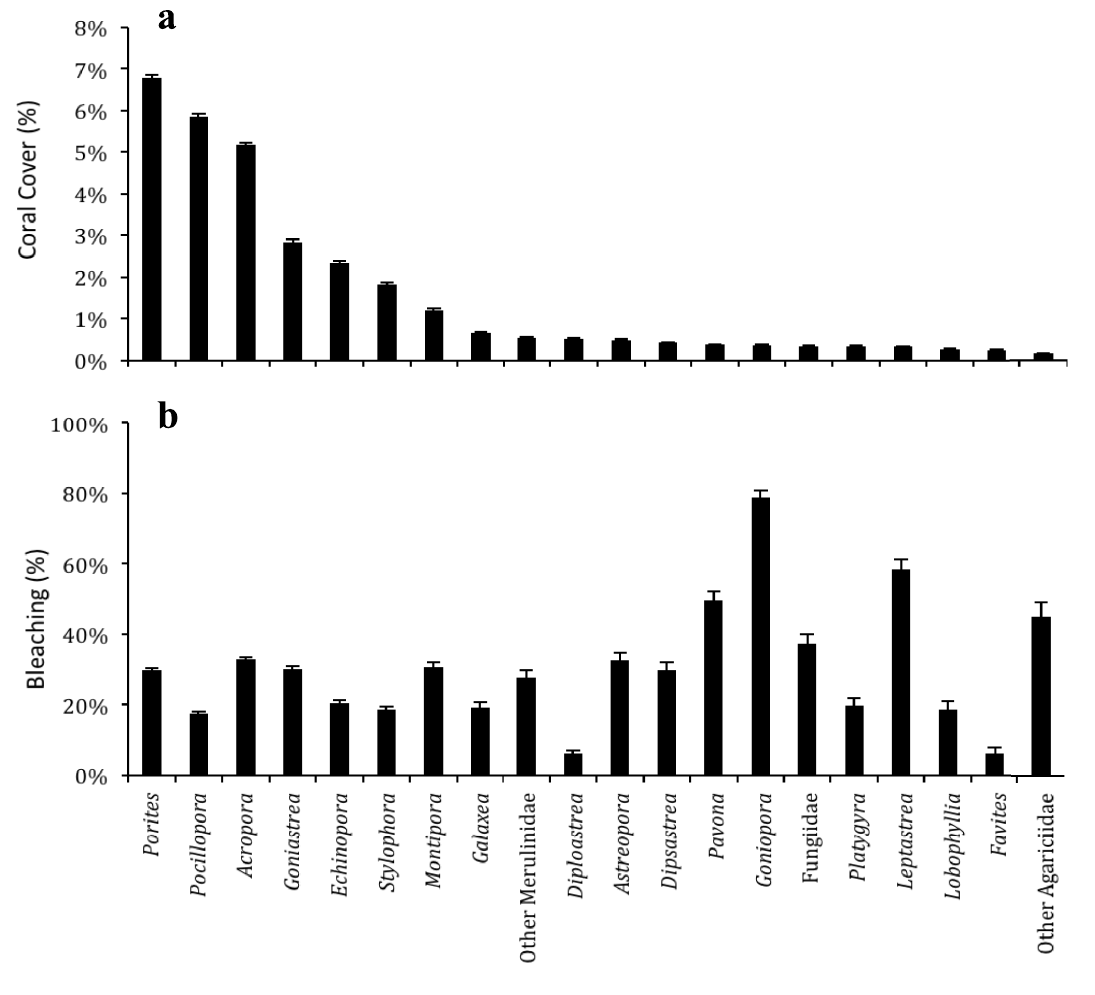
Fig 4. Percentage of scleractinian coral cover and their sensitivity to thermal stress during a bleaching event in the central Saudi Arabian Red Sea. a Average percent coral cover of the 20 most common taxa on all 10-m transects. b Average percent of bleached coral cover within each